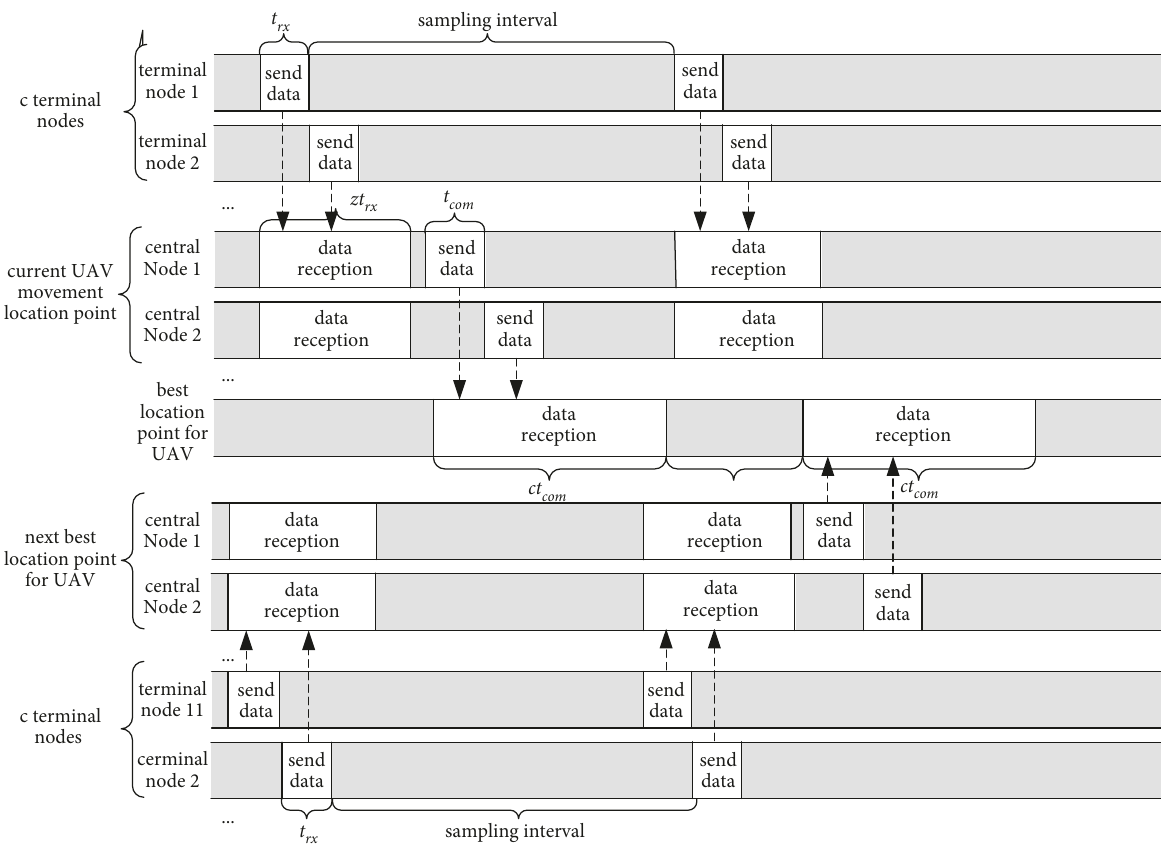
Figure 6: Temporal allocation of terminal node, central node, and UAV.